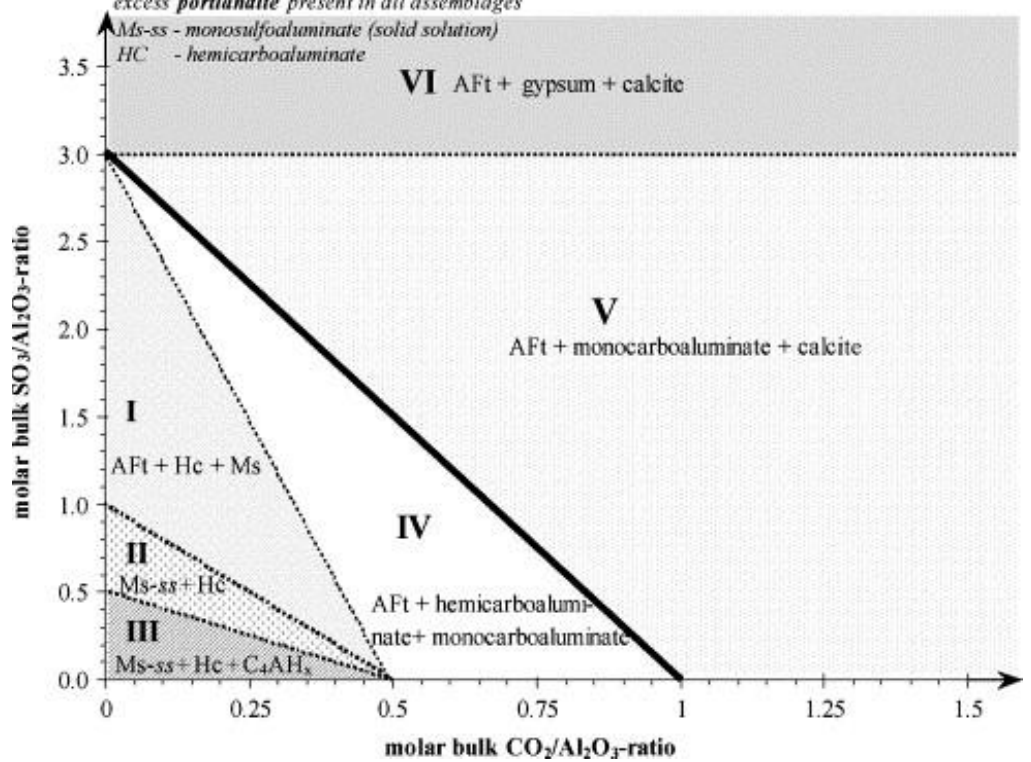
Figure 4. Calculated phase assemblages of a hydrated mixture consisting of C 3 A, Ca(OH) 2 and varying initial sulfate (SO 3 /Al 2 O 3 ) and carbonate ratios (CO 2 /Al 2 O 3 ) at 25 °C (molar units) [24]. Materials 2019 , 12 , x FOR PEER REVIEW